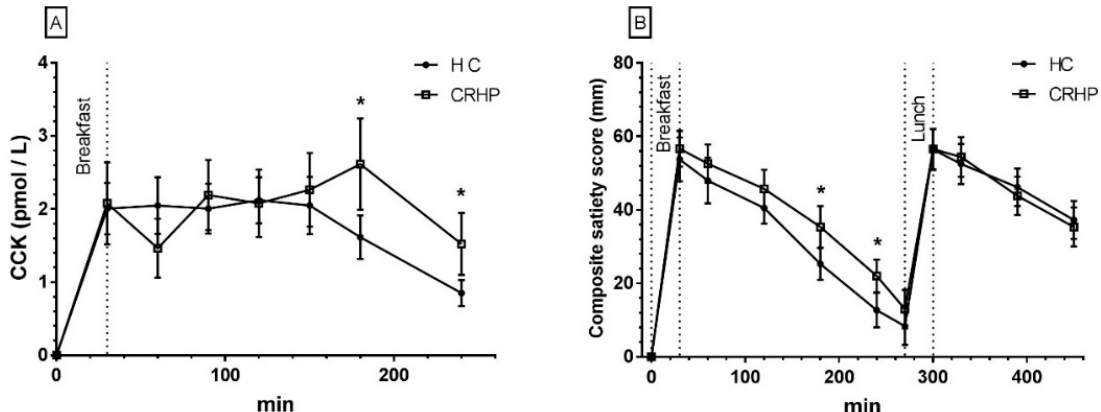
Figure 5. Mean ± SEM 4-h concentrations of CCK ( A ) in 14 non-diabetic subjects after intake of a CRHP or HC breakfast and 7.5-h composite satiety score on a 100-mm VAS scale ( B ) after intake of a CRHP or HC breakfast and lunch, respectively (mean of two consecutive days on each diet). * Significant difference ( p < 0.05) between HC and CRHP diet. HC: high carbohydrate; CRHP: carbohydrate-reduced high-protein; CCK: cholecystokinin; VAS: visual analogue scale.